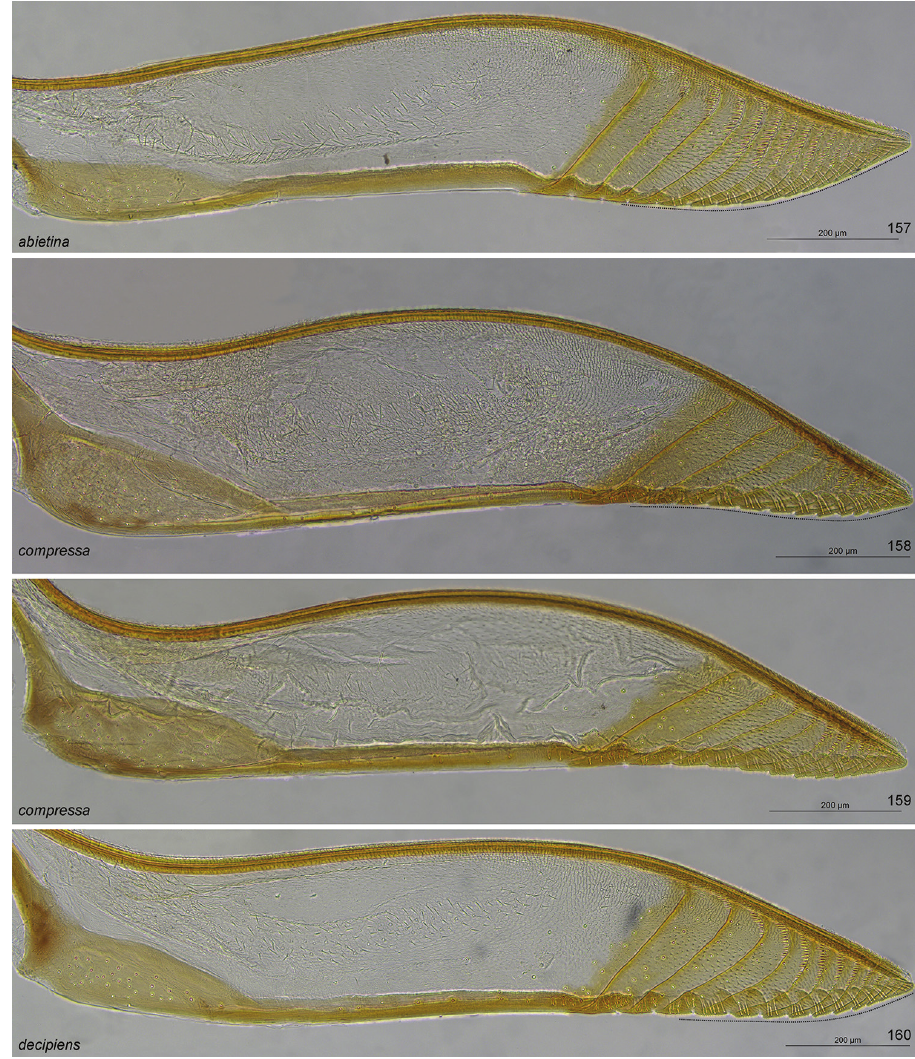
Figures 157–160. Lancets of Pristiphora . 157 abietina DEI-GISHym5174 158 compressa DEI- GISHym31606 159 compressa DEI-GISHym11922 160 decipiens